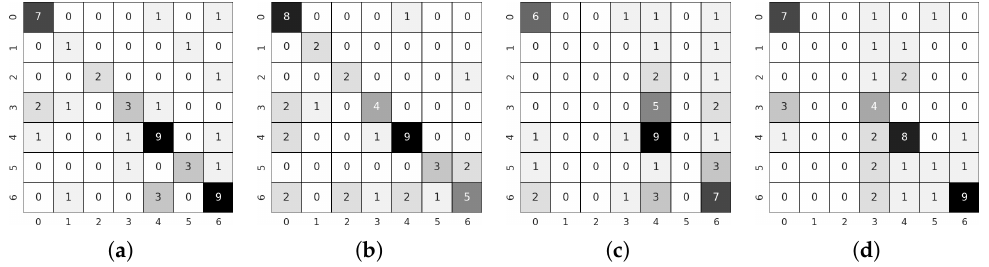
Figure 18. Different frame length test. ( a , b ) ResNet3D model with input at 15 or 6 fps. ( c , d ) X3D model with input at 15 or 6 fps. Dataset: Alcalá-1, test-split, 51 total intersections.